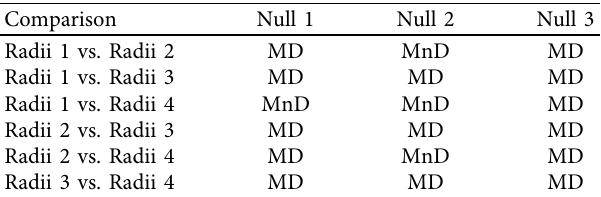
Table 17: Tukey–Kramer comparison test. MD means diferent. MnD means not diferent.